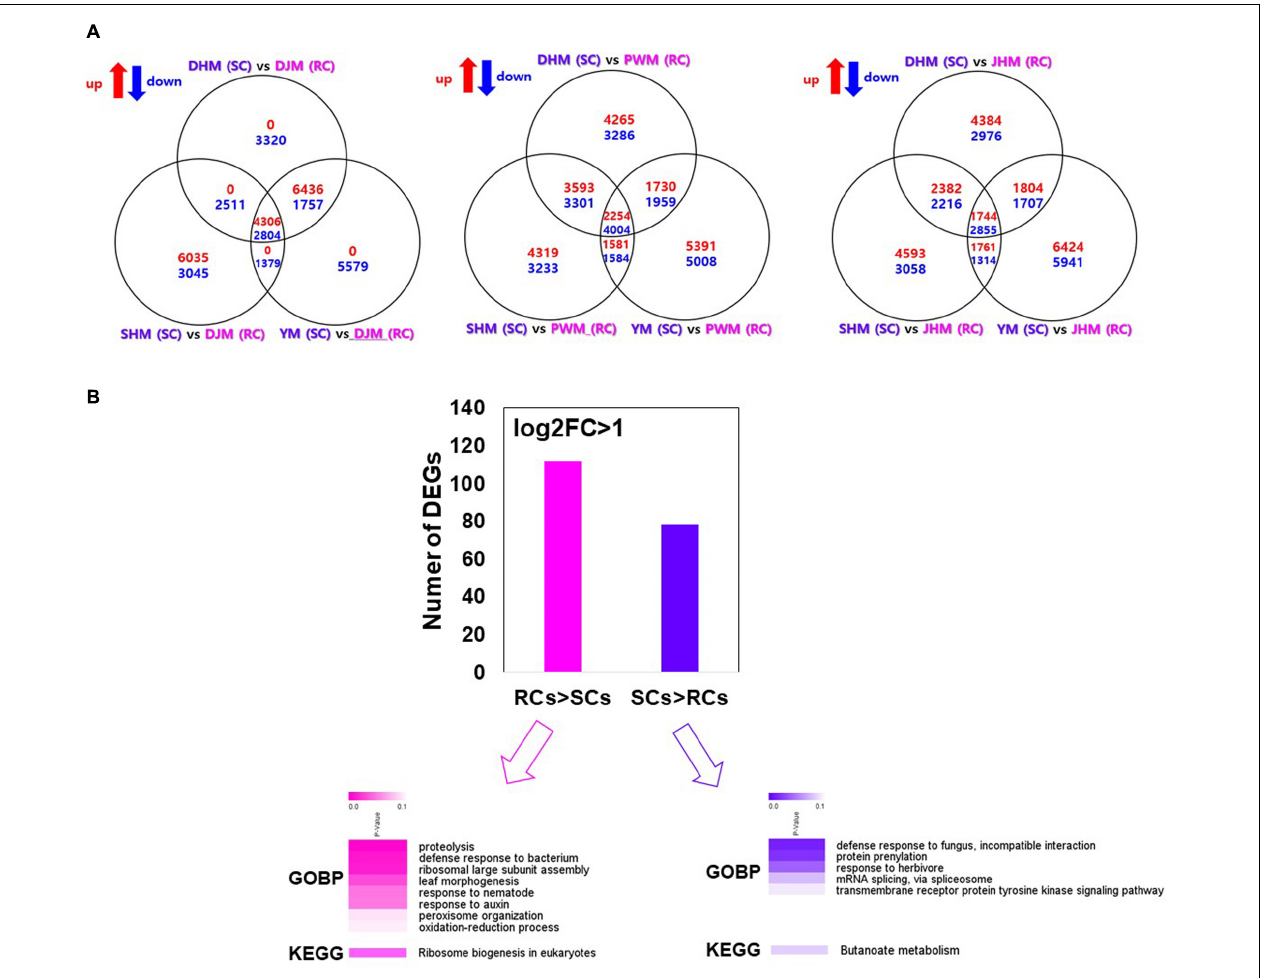
FIGURE 6 | Identification and GO enrichment analysis of sweetpotato genes involved in constitutive defense response against M. incognita infection. (A) Venn diagrams showing the number of genes differentially up- or downregulated in pairwise sample comparisons. (B) Heatmap of the GO and KEGG enrichment analyses of genes differentially expressed between RCs and SCs. The heatmap shows Benjamini–Hochberg-adjusted ( P < 0.05) for the biological process GO terms and KEGG pathways associated with DEGs. DHM, Dahomi; DJM, Danjami; PWM, Pungwonmi; SHM, Shinhwangmi; JHM, Juhwangmi; YM, Yulmi.